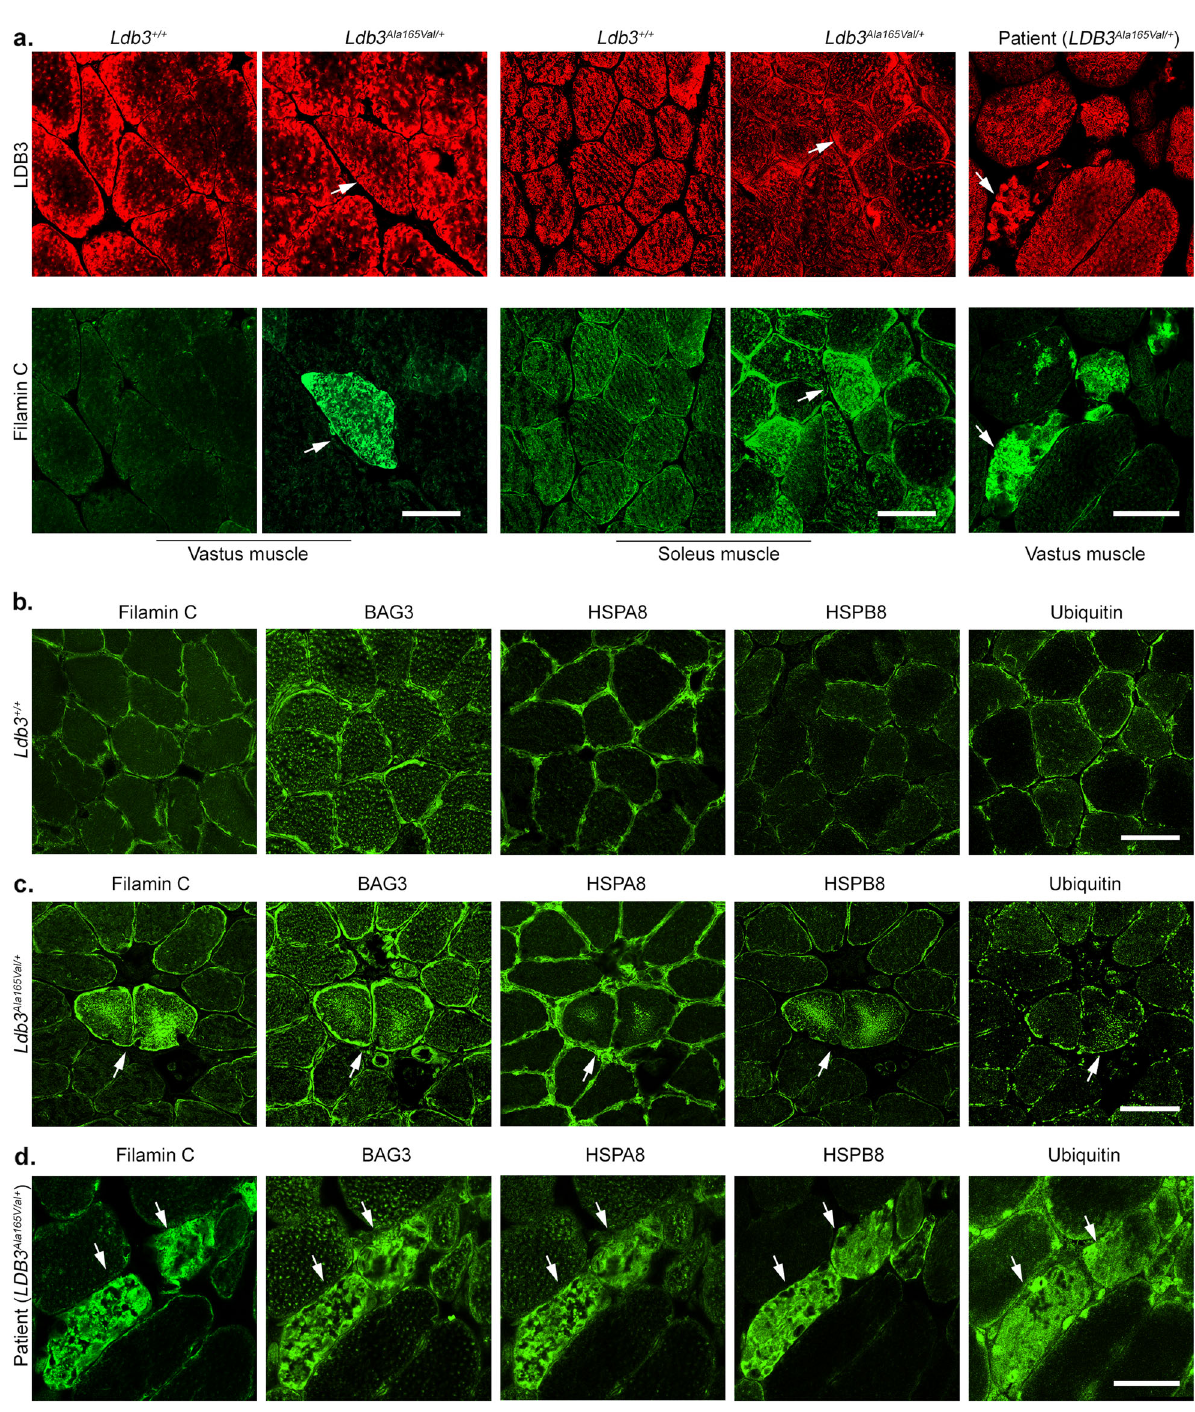
Fig. 3 Immunolocalization of fi lamin C and CASA chaperone complex in skeletal muscle of Ldb3 Ala165Val/ + mice and patients sharing the same mutation. a Representative immuno fl uorescence on frozen vastus lateralis and soleus muscle transverse section of 6-month-old Ldb3 Ala165Val/ + mice ( n = 9 and 5, respectively) and Ldb3 + / + littermates ( n = 5) and an MFM patient ( n = 3) with the LDB3 p.Ala165Val mutation stained with fi lamin C and LDB3 antibodies. White arrows indicate muscle fi bers with sarcoplasmic fi lamin C aggregates that have normal sarcoplasmic LDB3 distribution in Ldb3 Ala165Val/ + mice and relatively less extensive LDB3 accumulations in the patient. b – d Representative immuno fl uorescence on frozen soleus muscle serial transverse sections of 8-month-old Ldb3 + / + mice ( b ; n = 6) and Ldb3 Ala165Val/ + littermates ( c ; n = 8), and the vastus lateralis muscle of patient ( d ; n = 3) stained with fi lamin C, BAG3, HSPA8, HSPB8, and ubiquitin antibodies. White arrows indicate same muscle fi bers with sarcoplasmic accumulations of fi lamin C and the CASA proteins in Ldb3 Ala165Val/ + mice and patient. Such protein aggregates are not seen in the sections obtained from Ldb3 + / + mice. Scale bars = 50 μ